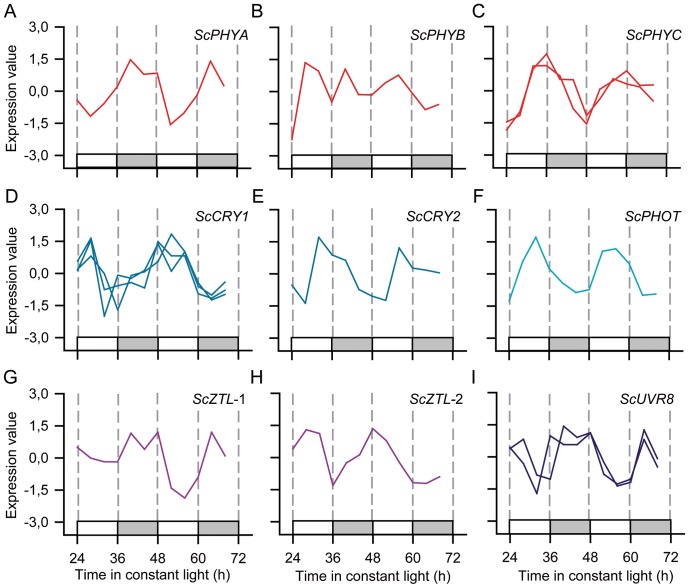
Time courses of probes associated with the perception of light.Z-score normalized time courses of rhythmic probes for sugarcane transcripts associated with the perception of light. Expression levels were measured using oligoarrays. Different probes for the same sugarcane genes are represented separately. (A) PHYTOCHROME A (ScPHYA), (B) ScPHYB, (C) ScPHYC, (D) CRYPTOCHROME1 (ScCRY1), (E) ScCRY2, (F) PHOTOTROPIN (ScPHOT) (G) ZEITLUPE (ZTL-1), (H) ZTL-2, (I) ScUVR8. White boxes represent periods of subjective day and light grey boxes represent periods of subjective night.